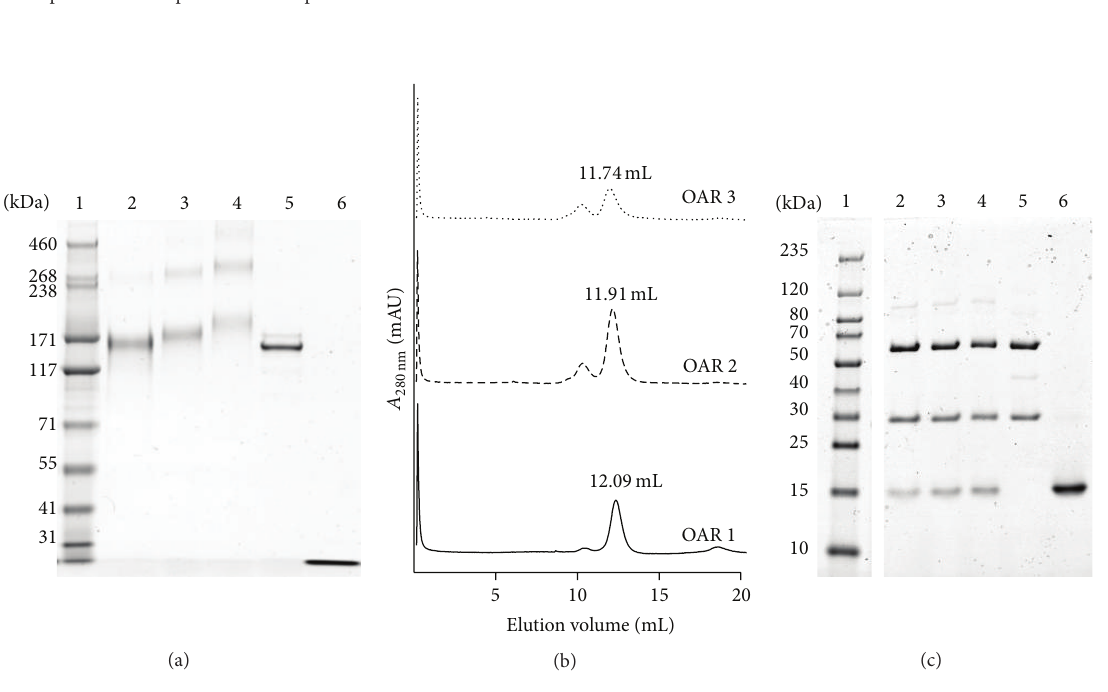
Figure 4: Purification of SPDP-based ADCs with distinct molar DAR. Ion exchange chromatography yielded immuno-RNases with distinct OARs as confirmed by SDS-PAGE under nonreducing (a) and reducing (c) conditions. Lane 1: molecular weight marker; lanes 2–4: ADCs with OARs of 1:1, 2: 1, and 3: 1 (1 𝜇 g each); lane 5: huRFB4 IgG (1 𝜇 g); lane 6: ONC (1 𝜇 g). (b) Size exclusion chromatography of IEX-purified immuno-RNases was performed on a Superdex 200 10/300 GL